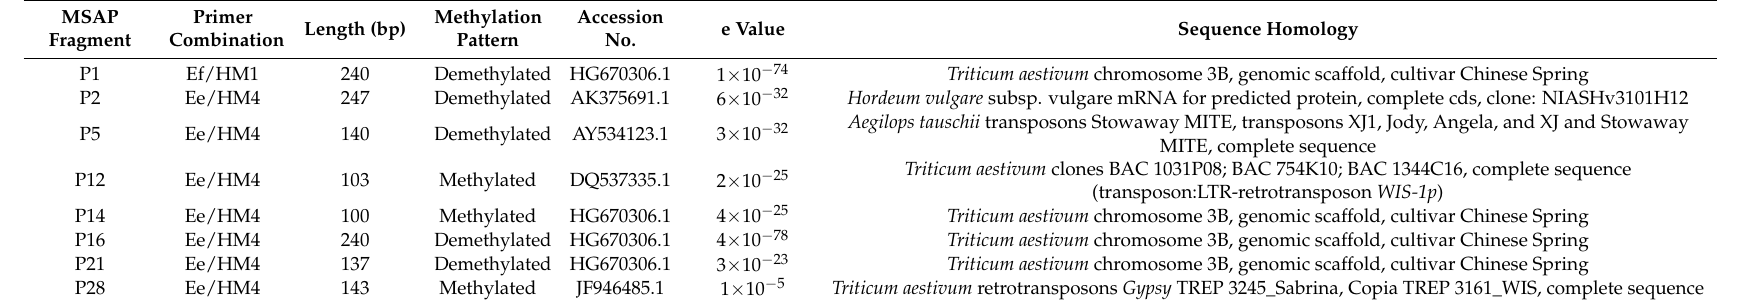
Table 4. BLAST (Basic Local Alignment Search Tool) results of eight randomly selected polymorphic methylated